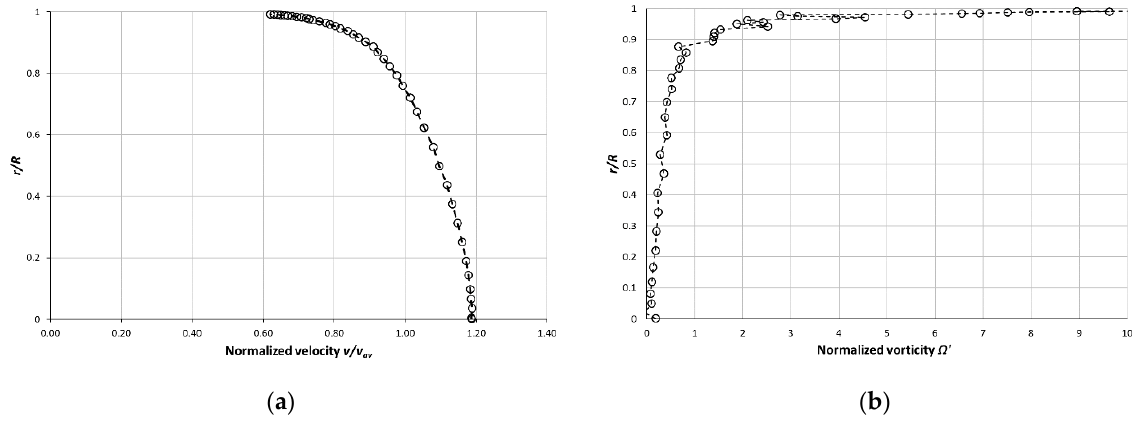
Figure 6. Normalized mean velocity profile acquired by experiment (PSP) and the corresponding normalized vorticity distribution over cross-section for Re = 230,460. ( a ) Normalized mean velocity profile; ( b ) Normalized vorticity distribution.